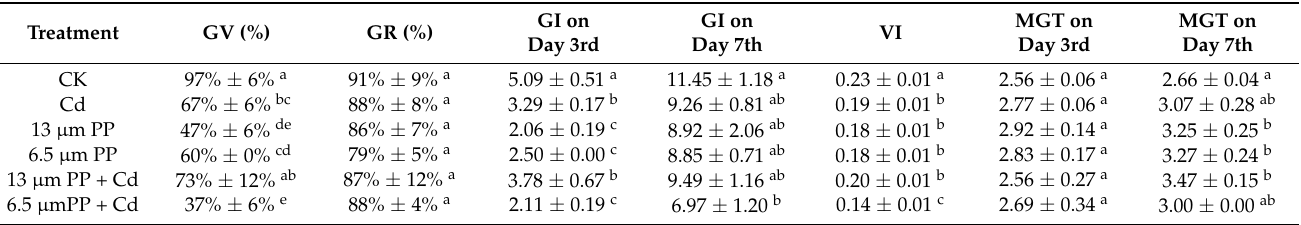
Table 1. Effect of single and combined treatment of PP-MPs and Cd on rice seed vigor/viability.